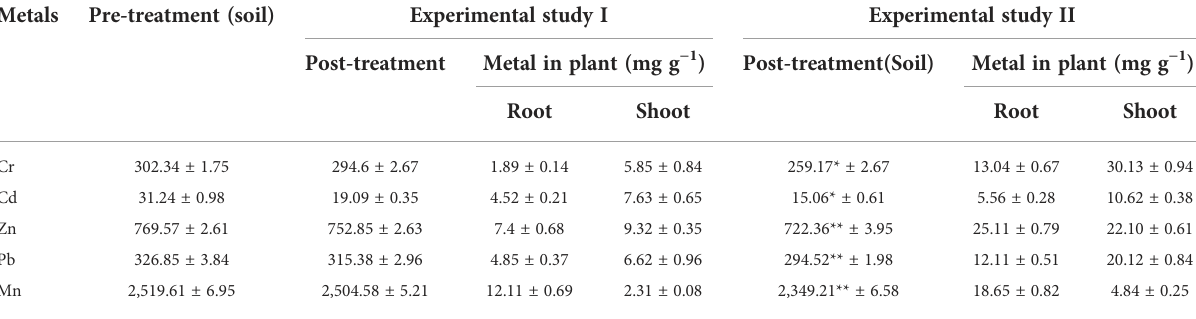
TABLE 2 Phytoremediation competence of C. juncea (L.) Millsp. in bauxite mine soil with and without the amalgamation of bacterial isolates. Pre-treatment